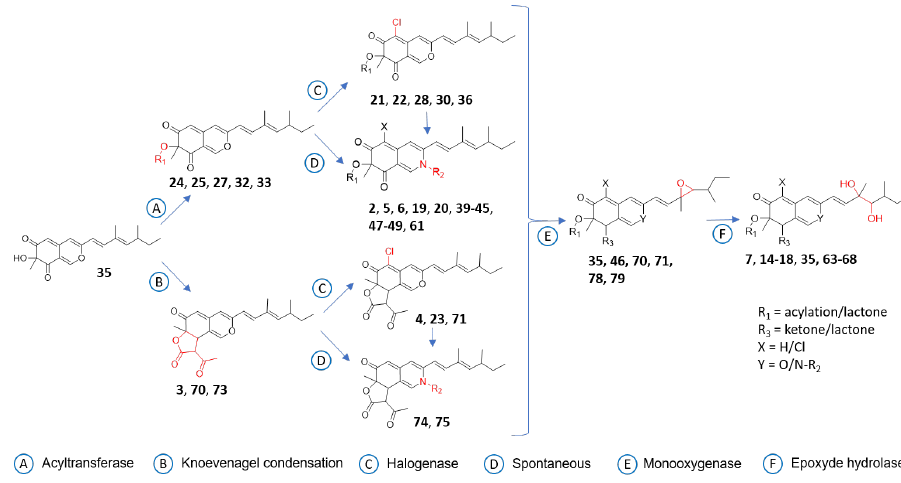
Figure 8. Summary of azaphilone modifications proposed as a metabolic pathway.